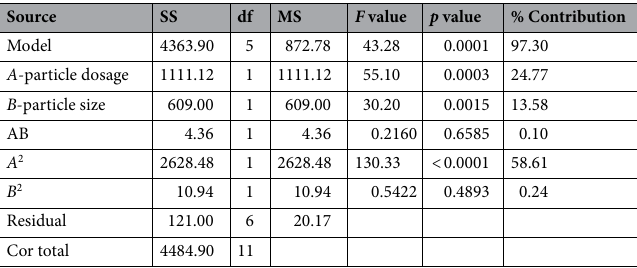
Table 3. ANOVA result on tensile strength (TS). SS sum of squares, MS mean square.